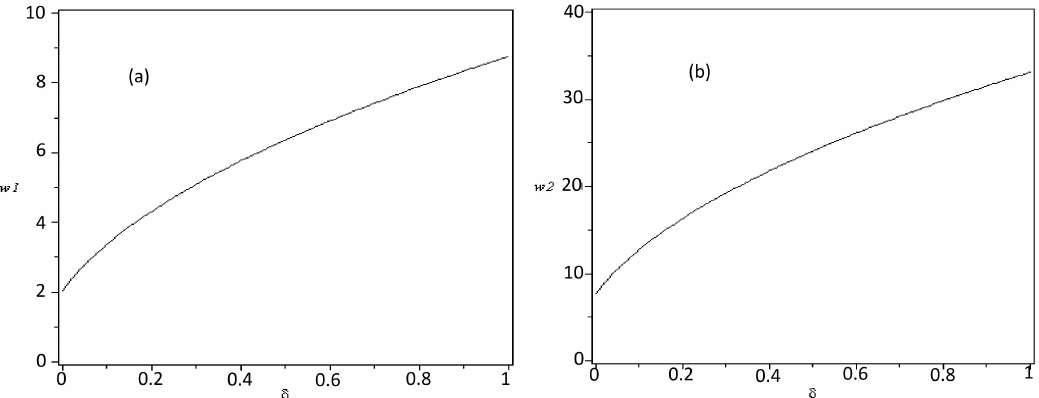
Figure 15. ( a ) Evolution of the first. ( b ) Evolution of the second. Circular natural frequency as a function of δ 1 (k 1